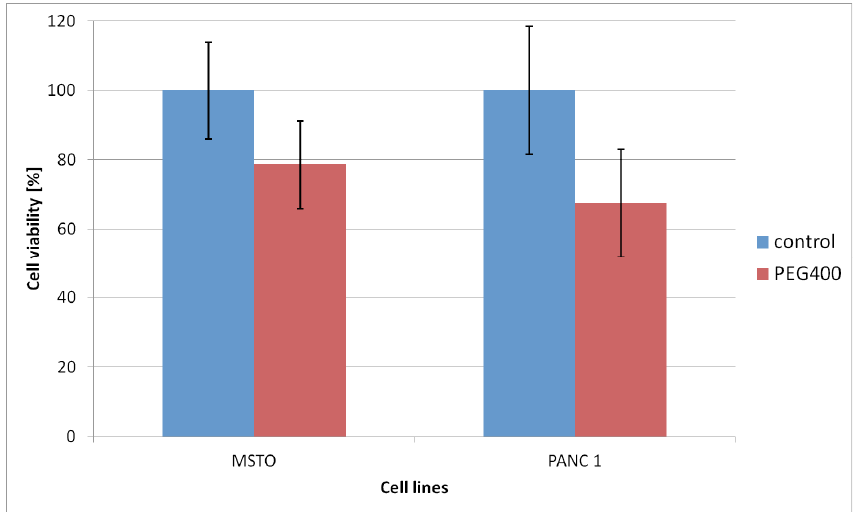
Figure 7. E ff ect of γ -PGA–PEG400 hydrogel on cellular viability (error bars, standard